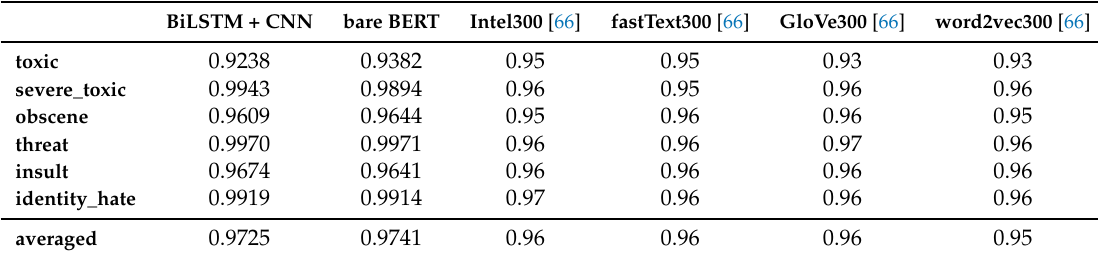
Table 20. Comparison of the accuracy of the BiLSTM + CNN and bare BERT with other similar